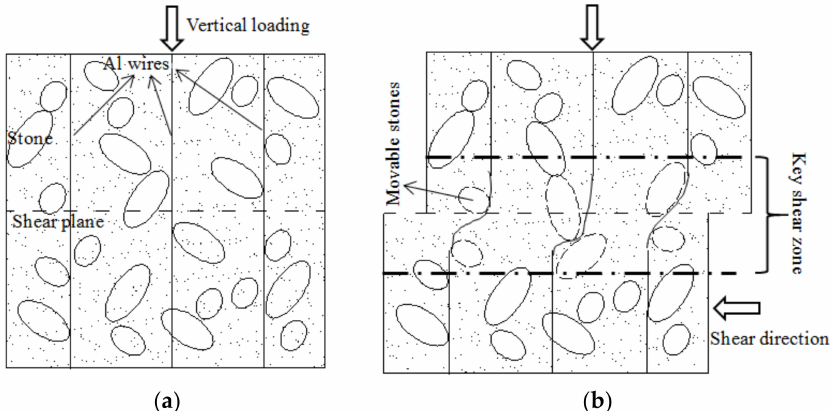
Figure 16. Schematic diagram of the movement state of block stones during shearing. ( a ) Before shearing; ( b ) after